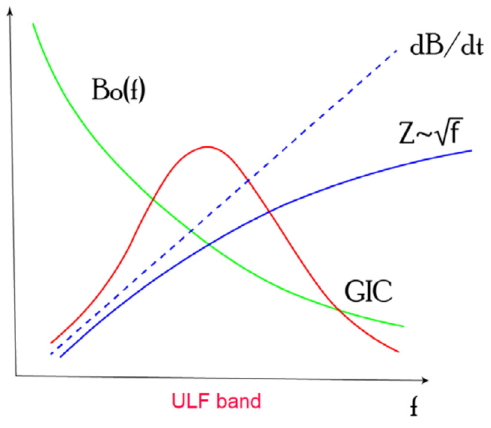
Figure 7. The amplitude spectra of horizontal magnetic ( H and E components) and telluric ( E H and E E components) field variations at station BEY during the 6 January 2019 event. Bottom panel shows the spectra of the magnetic field variability d H /dt and d E /dt.